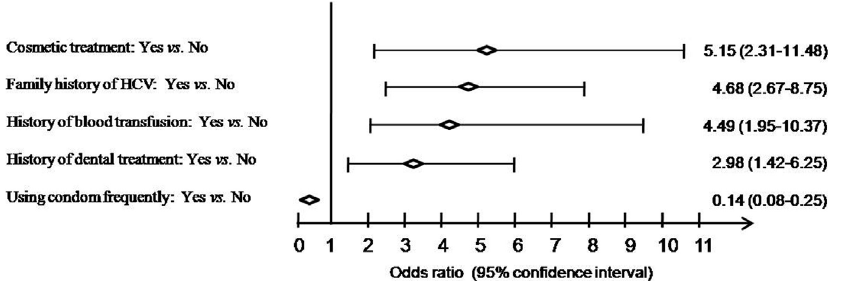
Figure 2. Odds ratio and 95% confidence interval was shown for the independent HCV risk factors by multivariate analysis. Cosmetic treatment, family history of HCV, history of blood transfusion, and history of dental treatment were risk factors, whereas using condom